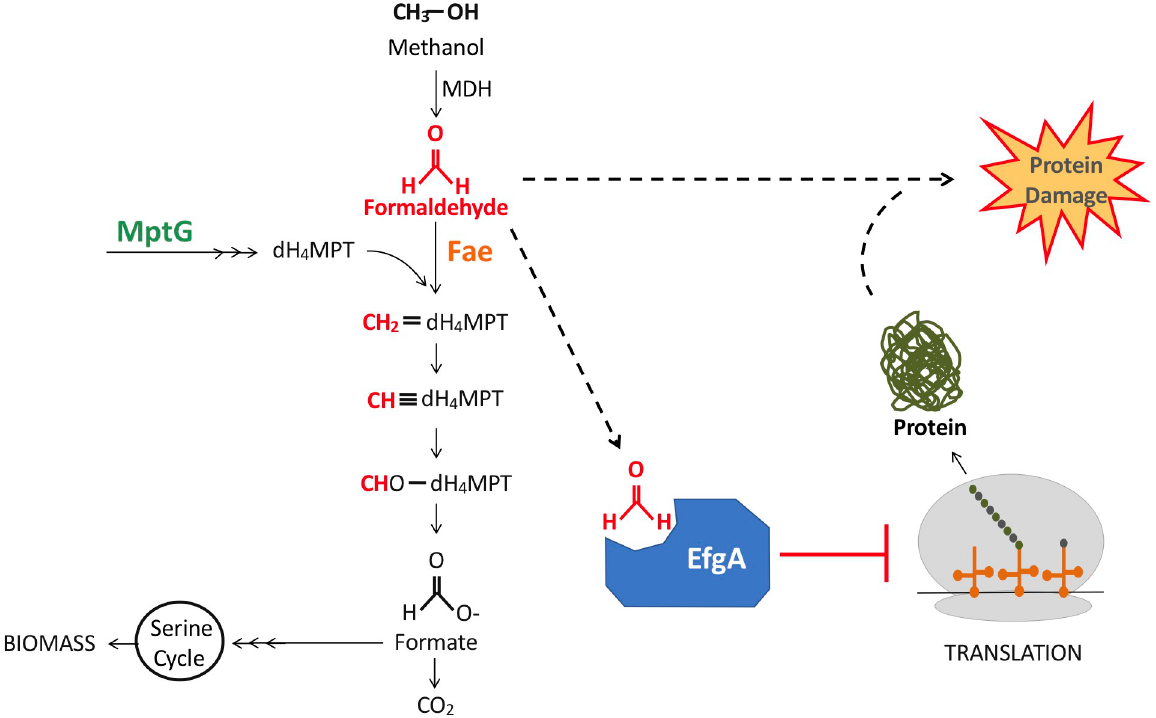
Fig 1. Methanol utilization pathway in M . extorquens . Methanol is oxidized to formaldehyde by MDH. Fae then condenses free formaldehyde and dH 4 MPT. MptG is required for dH 4 MPT biosynthesis. The pathway branches at formate which can be further oxidized to CO 2 or routed to the assimilation pathways (e.g., serine cycle). Alternatively, free formaldehyde can bind EfgA and lead to cessation of translation. Our working model is that EfgA prevents formaldehyde-induced protein damage. dH 4 MPT, dephospho-tetrahydromethanopterin; Fae, formaldehyde- activating enzyme; MDH, methanol dehydrogenase.